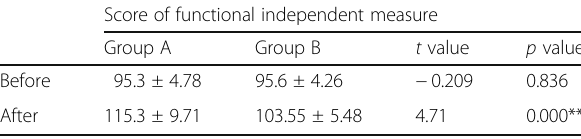
Table 5 Comparison of the mean score of FIM before and after treatment between